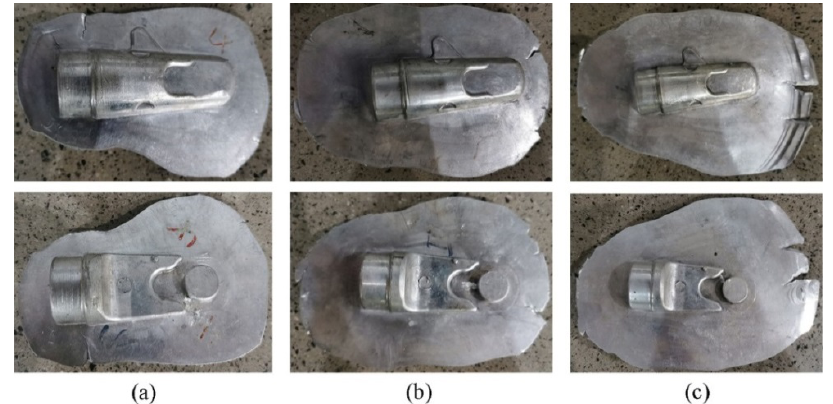
Figure 14. Formed aluminum components when lengths of bank are: ( a ) l = 55 mm, ( b ) l = 58 mm, and ( c ) l = 60 mm.